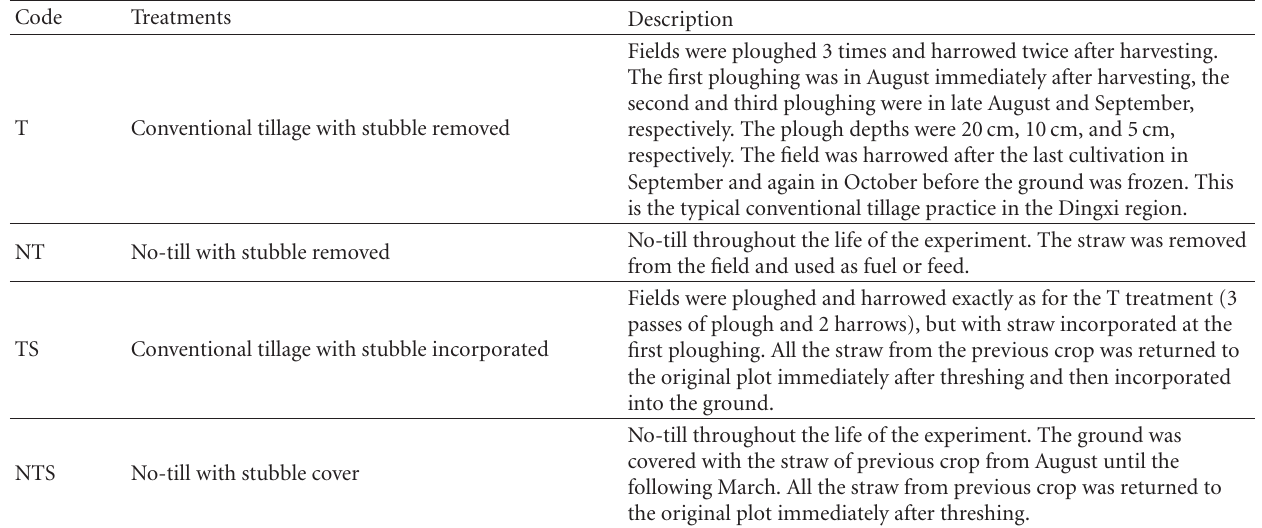
Table 2: Details of treatments used in the long-term conservation tillage